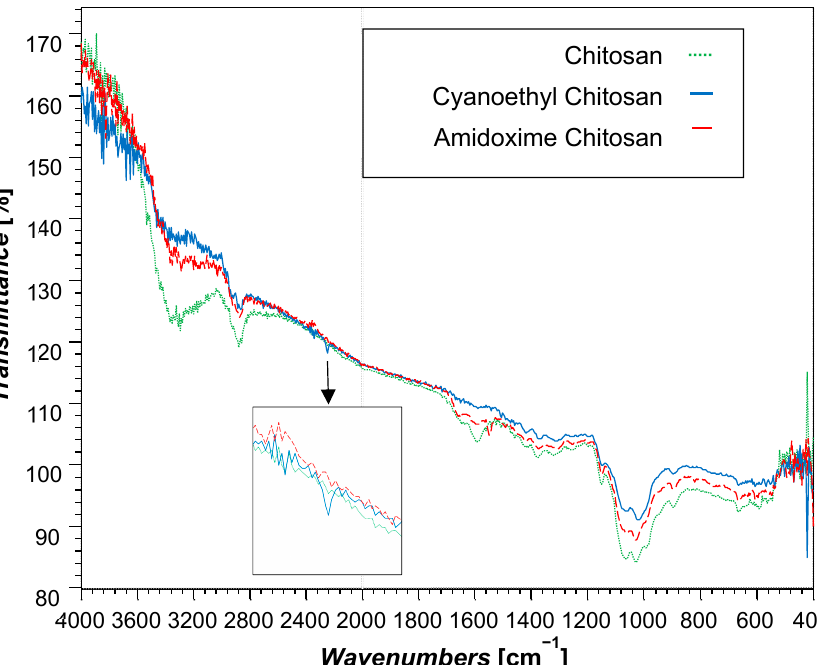
Figure 1. FT-IR spectrum of chitosan, cyanoethyl chitosan, and amidoxime chitosan. Figure 2A,B shows photo images of the chitosan/cellulose and amidoxime chitosan/ cellulose hydrogels after copper ion adsorption. The chitosan/cellulose hydrogel was uniformly blue, and the amidoxime-chitosan/cellulose hydrogels were green, suggesting that both hydrogels had different complexation mechanisms with copper ion. Both hydro- gels were stored in ion-exchanged water for three months and photo images are shown in Figure 2C,D. The surface of the chitosan/cellulose hydrogels (D) were disintegrated, and the amidoxime-chitosan/cellulose hydrogels (C) retained their spherical shape. The